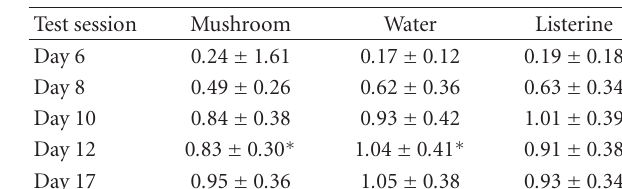
Table 1: Cumulative plaque index scores ( ± standard deviation) at the various test sessions during the treatment of volunteers with three di ff erent mouthwashes. Statistically significant di ff erences ( P < 0 . 05) are marked by ∗ .